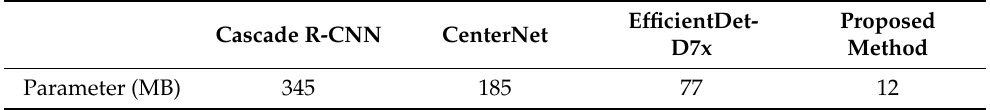
Table 5. The number of parameters for the four different methods.